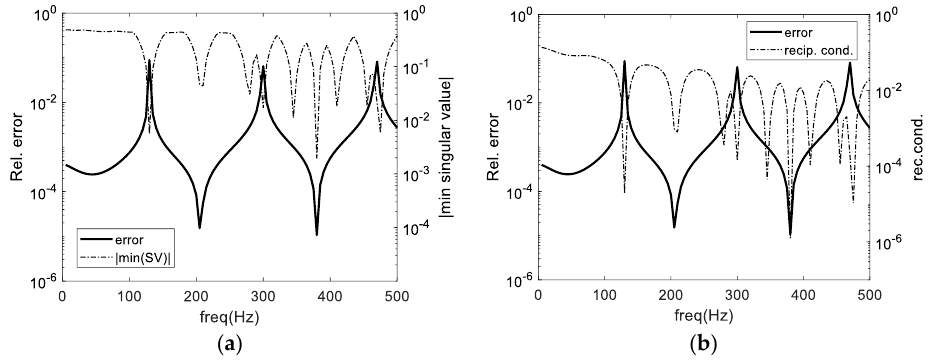
Figure 5. BEM relative error and ( a ) smallest singular value of the BEM matrix; ( b ) reciprocal of the condition number of the BEM matrix.